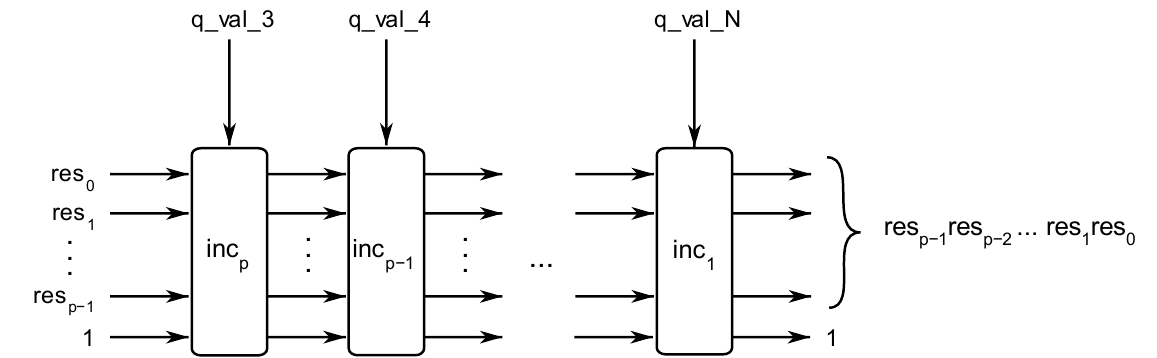
Figure 4. The design of the quantum addition circuit.